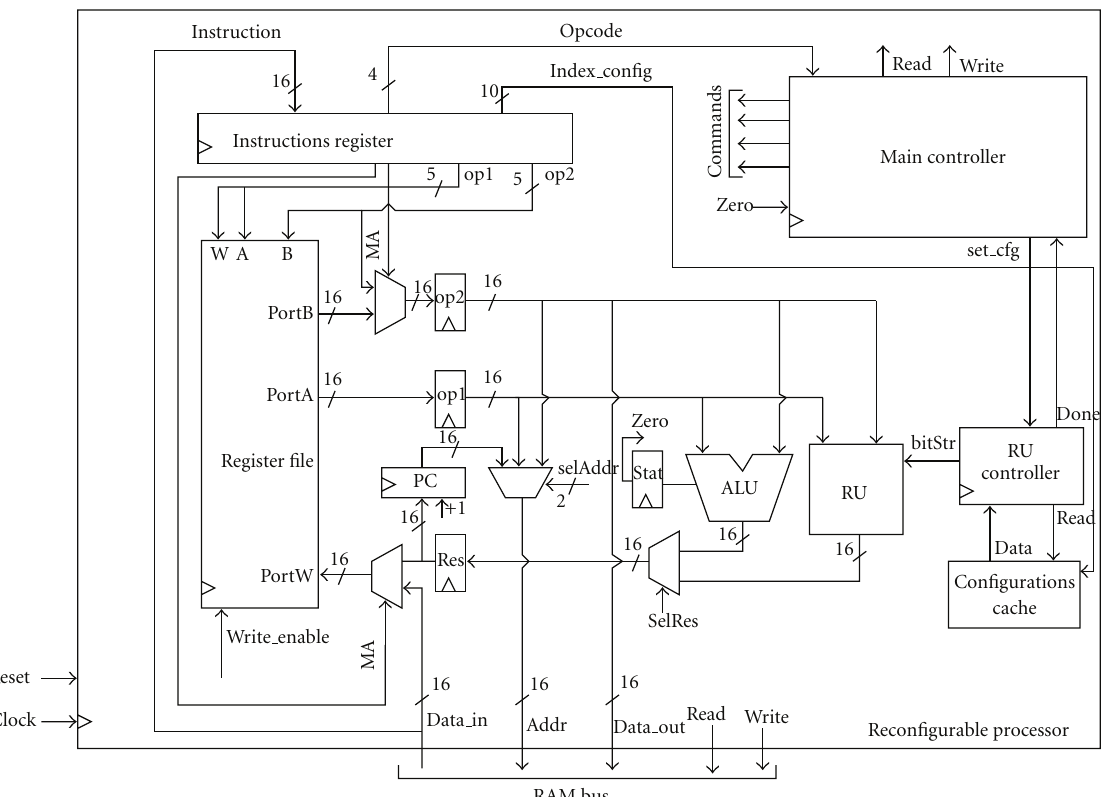
Figure 2: Schematic of the entire reconfigurable